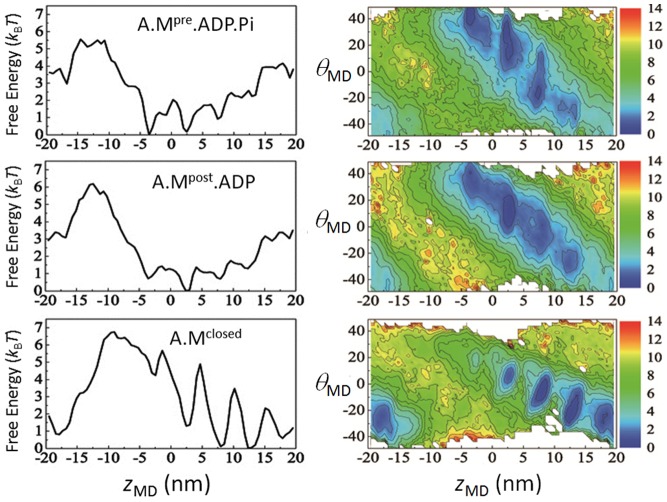
Free-energy landscapes of actin-myosin interactions.Two-dimensional free-energy landscapes are drawn in the plane of the coordinate of the center of mass of the myosin head  as contour maps in units of  (right), and one-dimensional free-energy landscapes on the coordinate  (left). Landscapes in A. Mpre.ADP.Pi (top), A.Mpost.ADP (middle), and A.Mclosed (bottom).